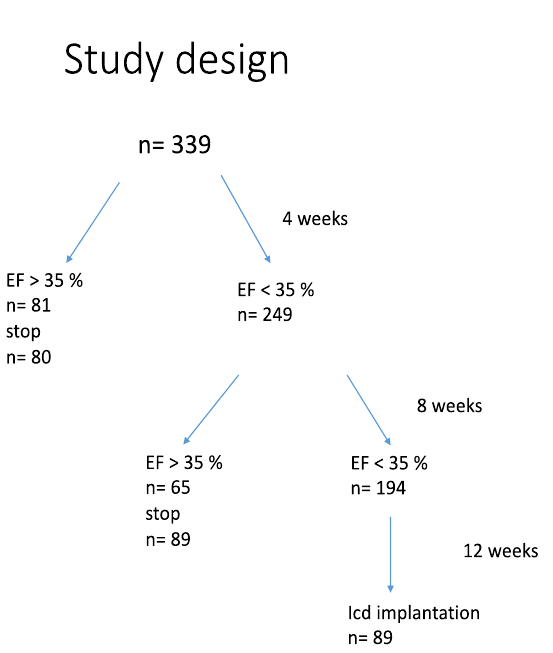
Figure 4. Number of ICD implantations after uptitration and without uptitration (uptitration = any increase in medication dosage). ICD = Implantable cardioverter defibrilator